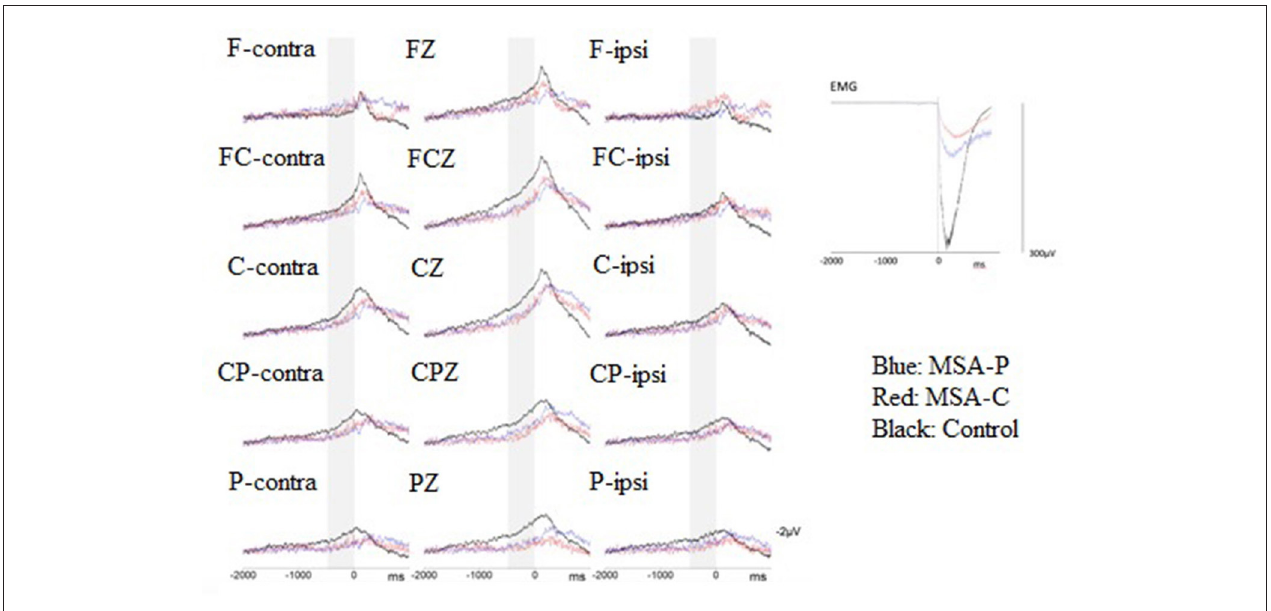
FIGURE 1 | Superimposition of the grand-average Bereitschaftspotential (BP) from patients with multiple system atrophy (MSA)-P ( n = 8, blue lines), patients with MSA-C ( n = 8, red lines), and healthy controls ( n = 8, black lines) were revealed at the 15 electrodes of interest when performing volition wrist extension. The zero denotes the onset of a surface electromyogram (sEMG) burst. Gray stripes represent the late BP period (500–0ms before volitional sEMG burst onset). Grand averages of the voluntary sEMG burst during performance of wrist extension movements are shown at the right-hand part of this figure.